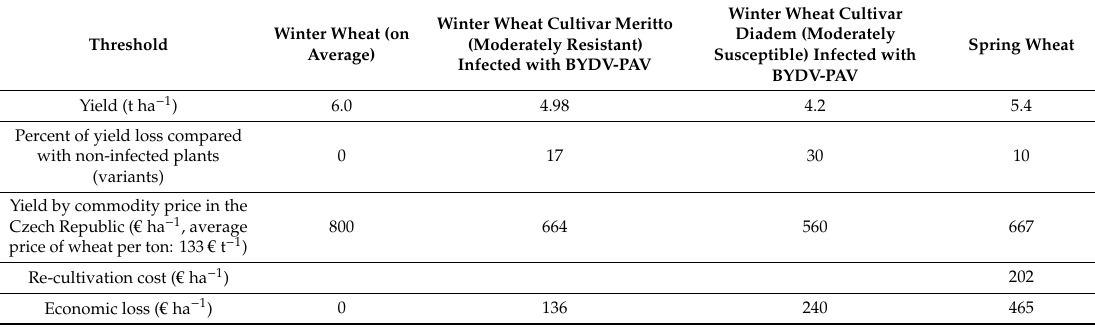
Table 6. Evaluation of economic thresholds of winter wheat cultivars due to BYDV-PAV infection compared with spring wheat cultivars.